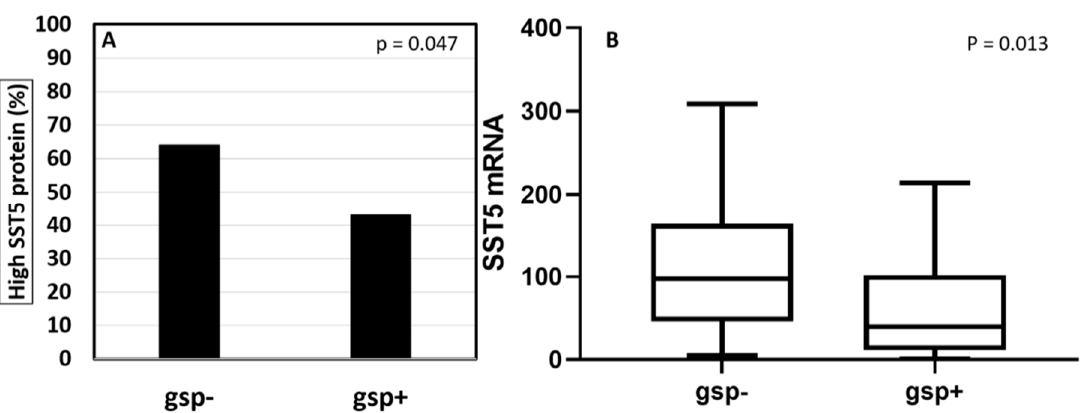
Figure 3. gsp mutation and SST5 protein ( A ) and mRNA ( B ) expression. Three outliers from the gsp - group (666, 1075, and 1318 copies) and one from the gsp + group (214 copies were excluded from the graph for better visualization). Table 1. Comparison of demographic, laboratory, imaging, molecular, histopathological, and treatment response to first-generation somatostatin receptor ligands data between gsp+ and gsp- tumors.